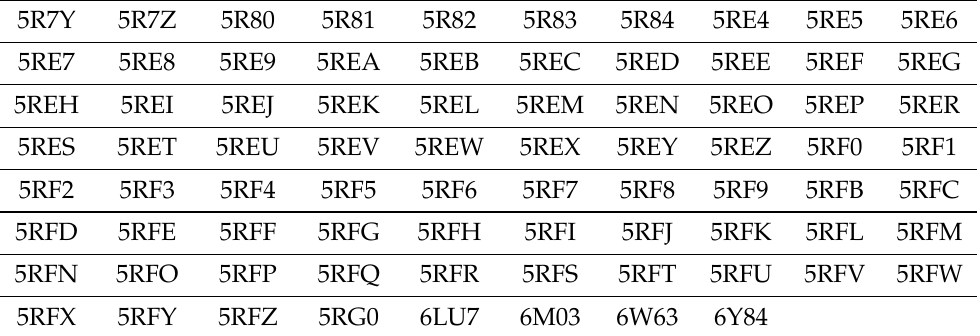
Table 1. PDB IDs of SARS-CoV-2 M pro